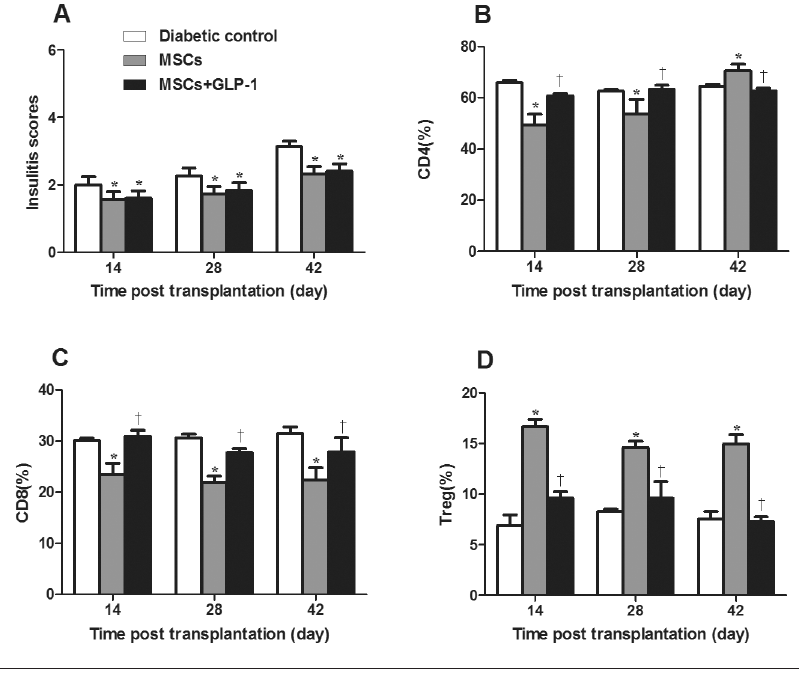
Figure 4. Treatment with MSCs and GLP-1 modulates inflammation in NOD mice. Following treatment with MSCs and GLP-1 or MSCs alone, some mice from the groups of diabetic mice were euthanized at the indicated time points post treatment and the degree of in- flammatory infiltrates in the pancreatic islets was examined. The frequency of splenic CD4 + and CD8 + T cells and CD4 + CD25 + Foxp3 + Tregs was determined by flow cytometry. Data are expressed as the mean ± SEM of individual group of mice (n = 6 per group per time point) from three separate experiments. (A) Insulitis levels. (B) Percentages of splenic CD4 + T cells. (C) Percentages of splenic CD8 + T cells. (D) Percentages of splenic Tregs. * P < 0.05 versus diabetic controls. † P < 0.05 versus mice treated with MSCs